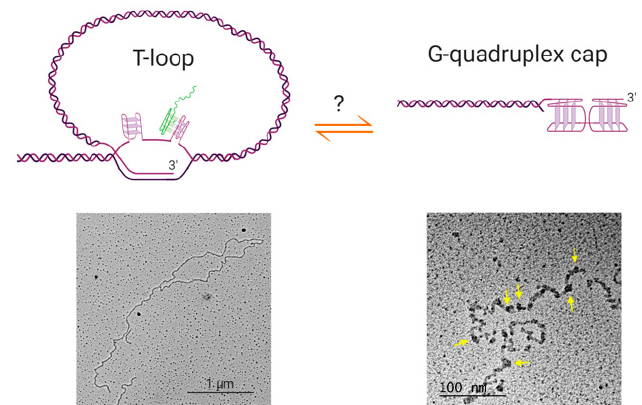
Figure 2. Possible relationships between t-loops and G-quadruplex structures. Top left: schematic of a t-loop formed by intercalation of a telomeric 3' overhang into the duplex portion of a telomere; it is also possible for the other strand to participate in stabilizing the junction [81]. It is possible that G-quadruplexes could form in the displaced G-strand (the “D-loop”), or involving the 3' overhang at the junction (not shown). It has been shown that RNA transcribed from telomeres (TERRA; green) localizes to the t-loop junction, possibly through DNA-RNA G-quadruplex formation [81]. Bottom left: electron microscopy image of a t-loop in genomic DNA isolated from human HeLa cells; image by Jack D. Griffith. Top right: it is possible that G-quadruplexes form at the telomeric overhang at times in the cell cycle when t-loops are resolved, although there is no direct evidence for this at present. Bottom right: Electron micrograph showing G-quadruplex formation in a long single-stranded telomeric fragment; image by Jack D. Griffith. Arrows indicate bead-like structures that represent higher-order interactions between multiple G-quadruplexes [82]. Figure created with BioRender.com.